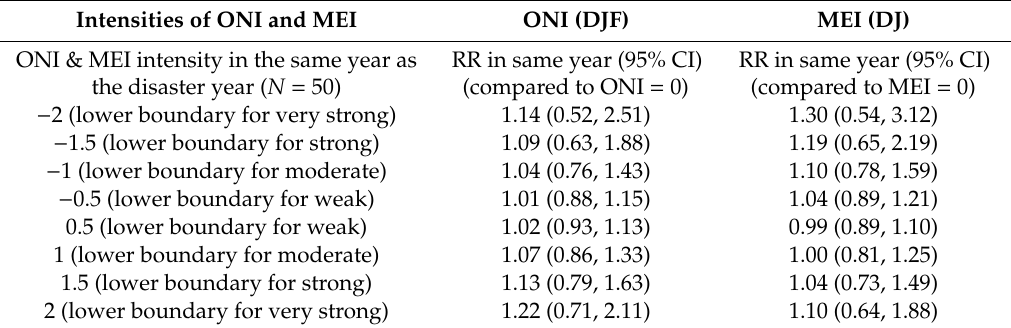
Table 2. Relative risks (RR) of global PAD rate associated with ONI and MEI in the same year as the disaster year, 1964–2017.